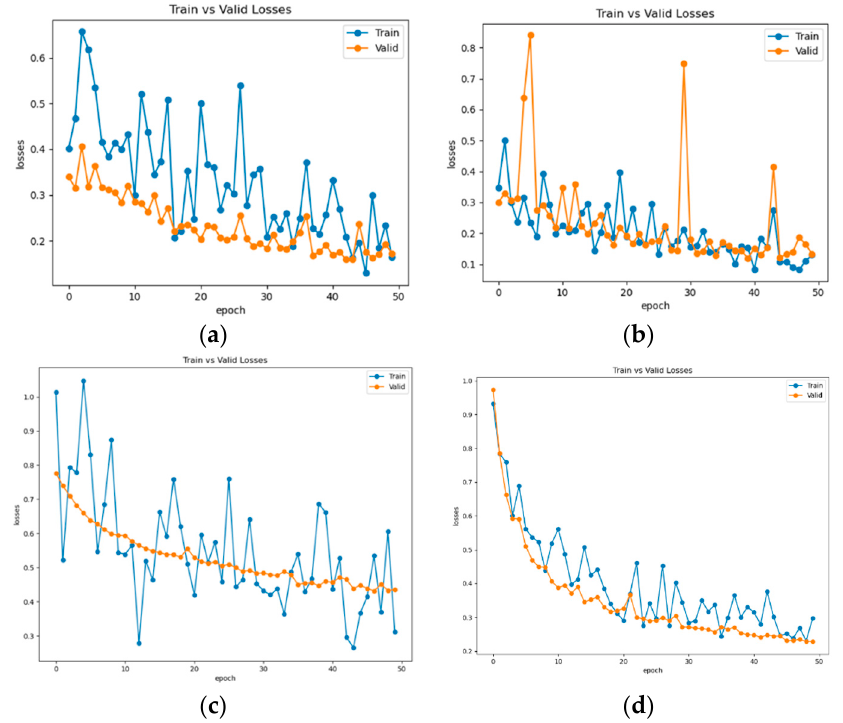
Figure 13. Training and validation loss values with different loss functions and optimizers: ( a ) Adam + BCE; ( b ) Adam + Focal loss; ( c ) SGD + BCE; and ( d ) SGD + Foal loss.